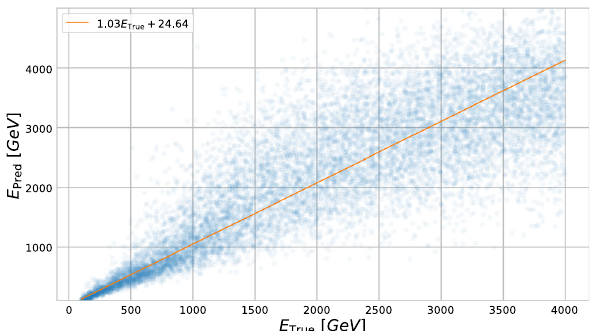
Fig. 8 Raw predictions of the regressor ensemble as a function of true energy. The ideal response is for all points to lie on a straight line along y = x. The green line shows a linear fit to predictions in bins of true